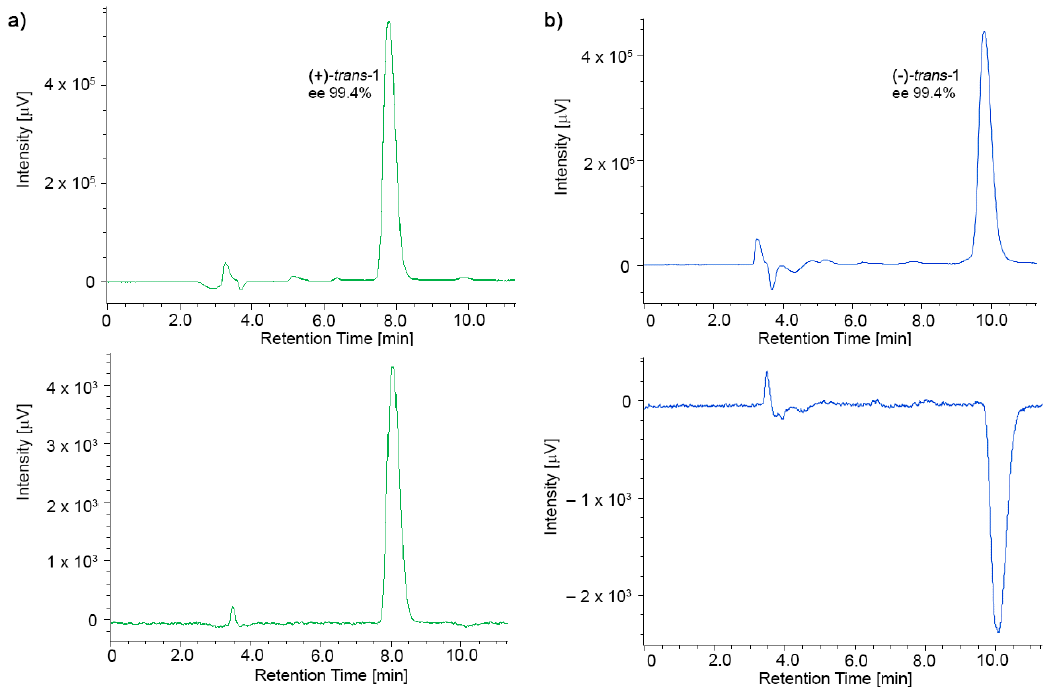
Figure 5. UV trace (up) and ECD trace (down) of the first eluted ( + )- trans - 1 ( a ) and the second eluted ( − )- trans - 1 ( b ) using Chiralpak IA, mobile phase M (Table 1).